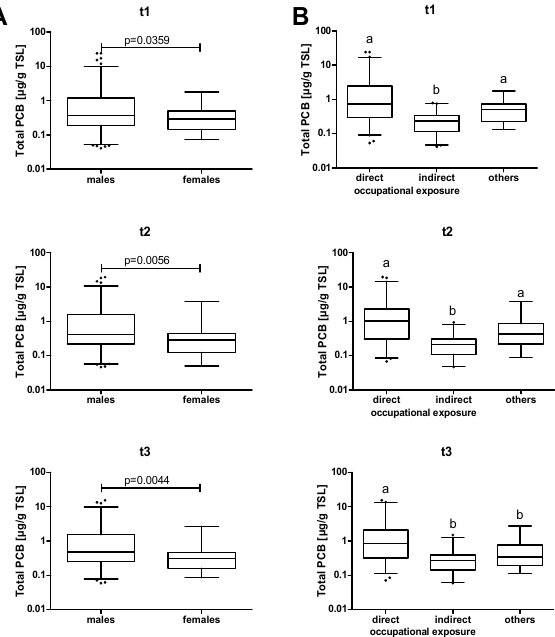
Figure 1. Total PCB burden. Data are shown as box plots depicting the median plasma concentrations. Whiskers represent the 2.5 to 97.5 percentiles. ( A ) Comparison between male and female subjects. Statistical significance of the difference between male and female subjects was calculated by Mann-Whitney U test. ( B ) Comparison between subjects depending on the route of exposure. Statistical significance was calculated by Kruskal-Wallis test. Statistically significant differences are indicated by the absence of shared letters.